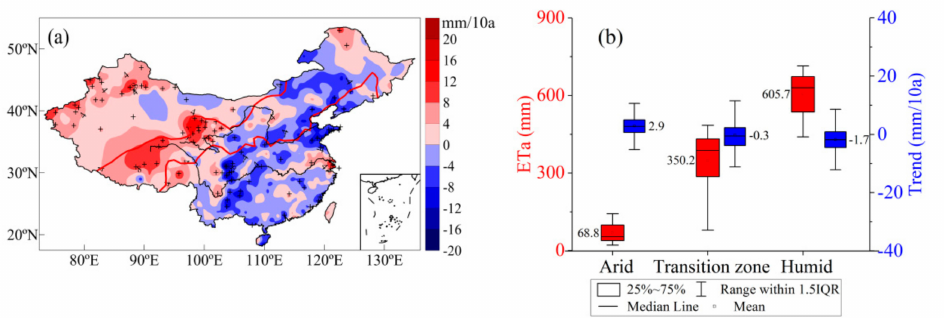
Figure 5. ET a trend (1960–2017) and ( a ) distribution of average values and trends in sub regions and ( b ) +indicates that the trend was significant at the 0.05 level.